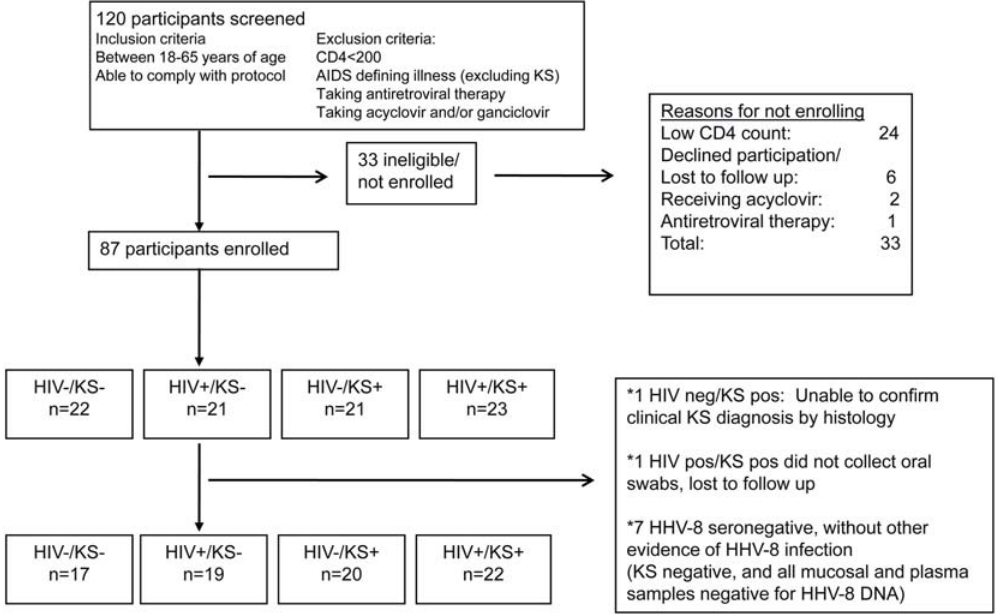
Figure 1. Enrollment and follow-up of participants in HHV-8 replication study.